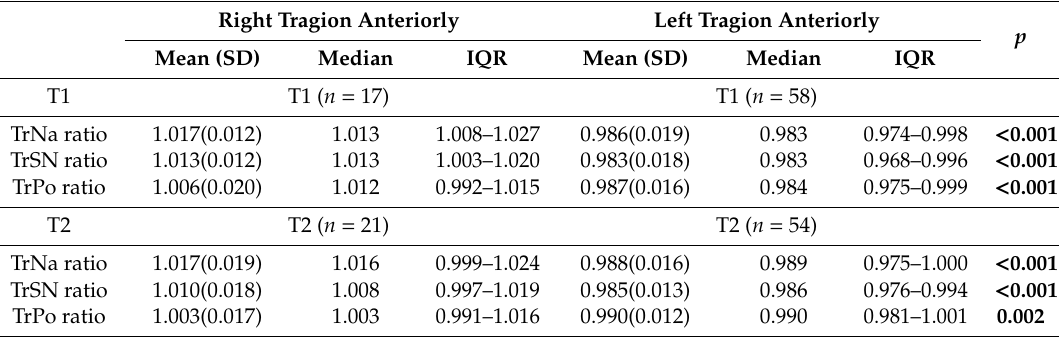
Table 5. Linear symmetry variables grouped by the side of the ear-o ff set (EO) at T1 and T2. SD = Standard deviation; IQR = Inter quartile range; Mann-Whitney nonparametric test was used to calculate p -values. Bold values denote statistical significance at the p < 0.05